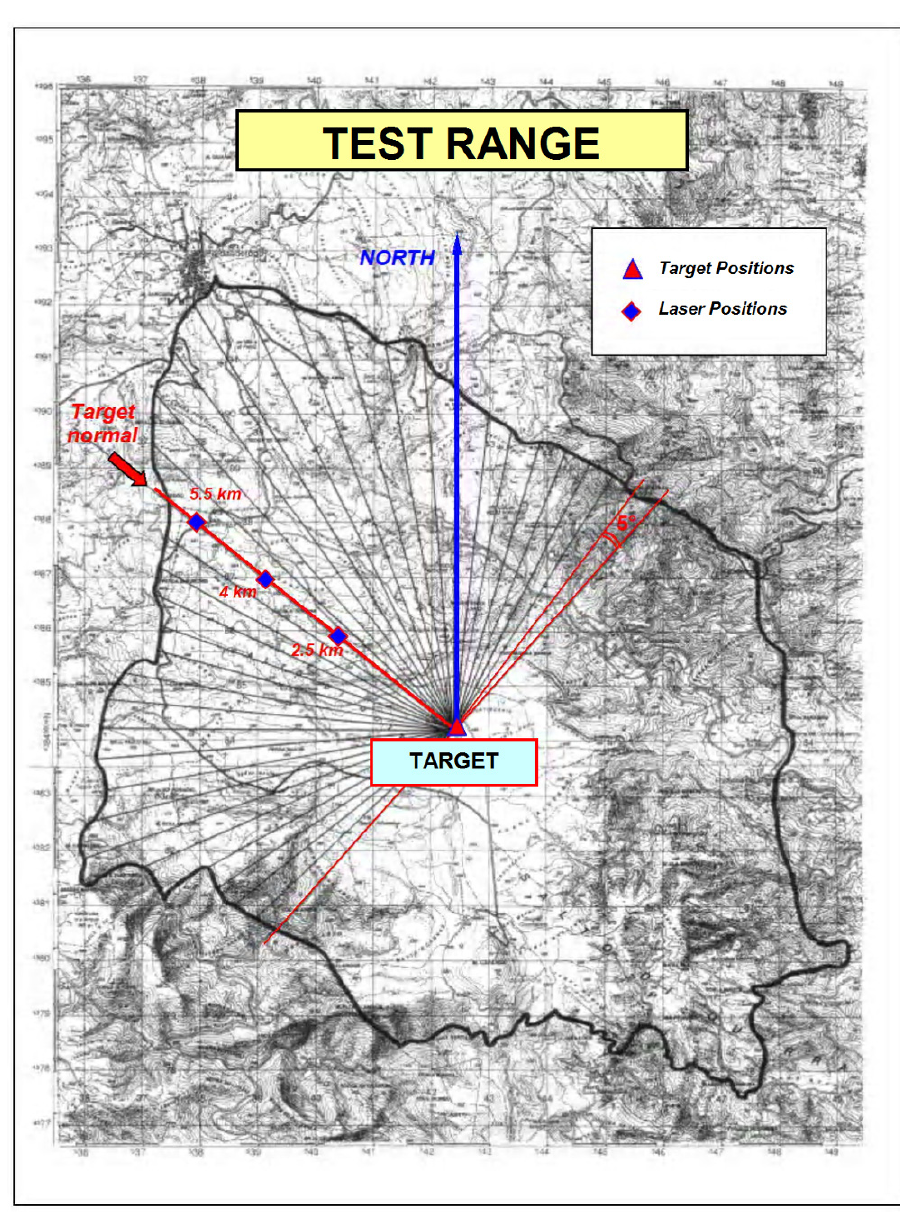
Figure 8. Geometry of atmospheric propagation measurements at λ = 1064